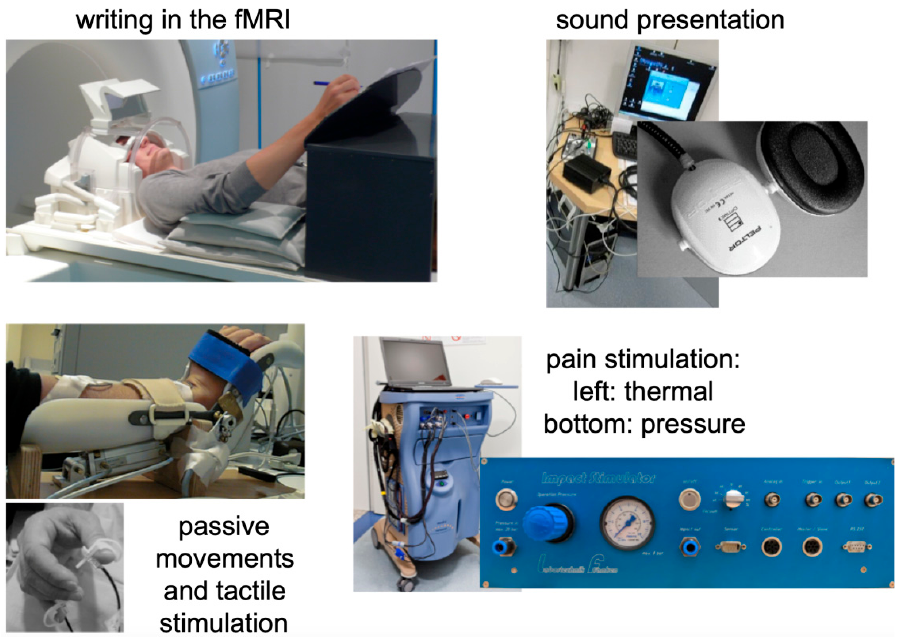
Figure 1. Experimental settings for the presentation of stimuli in the functional MRI scanner. Left top: writing table for fMRI investigations with a doubled-mirror system affixed above the head coil; right top: sound presentation system; left bottom: pneumatic stimulation system; right bottom: pain stimulation devices for thermal and pressure pain stimulation.